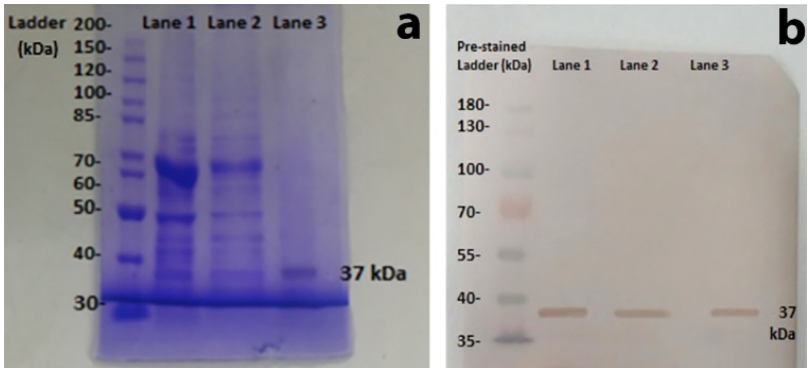
Figure 4. Western blot and SDS-PAGE results. ( a ) Purified FRs through SDS PAGE. Lane 1: crude sample containing sonicated HeLa cells; Lane 2: partial purification of folate receptor; Lane 3: magnetic affinity purified FR. ( b ) Western blot analysis of purified FR at 37 kDa molecular weight. Lane 1: crude sample containing crushed HeLa cells; Lane 2: partial purification of FR; Lane 3: magnetic affinity purified FR.